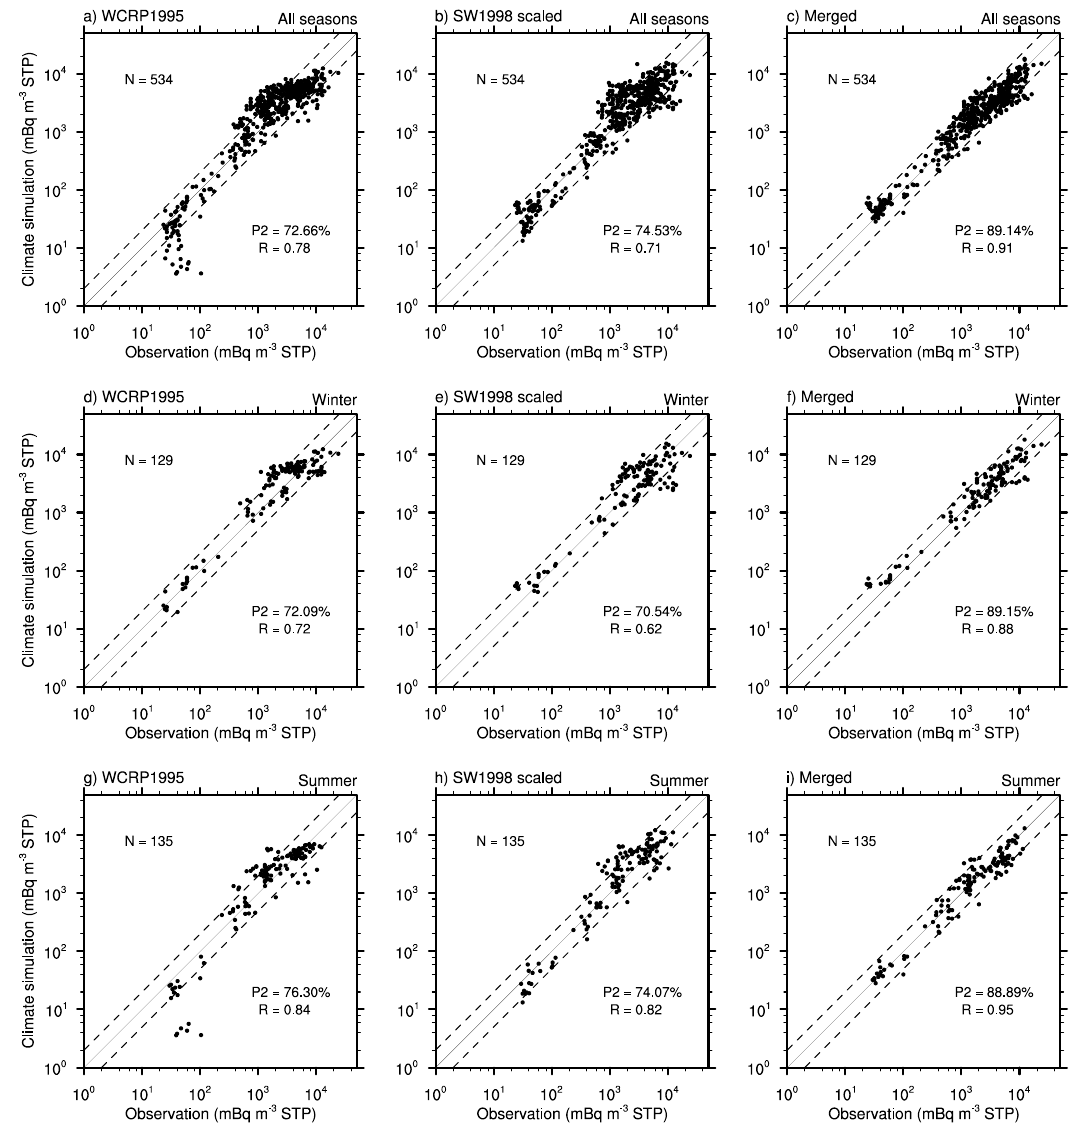
Fig. 6. Same as Fig. 4, but for the climatological simulations without nudging.